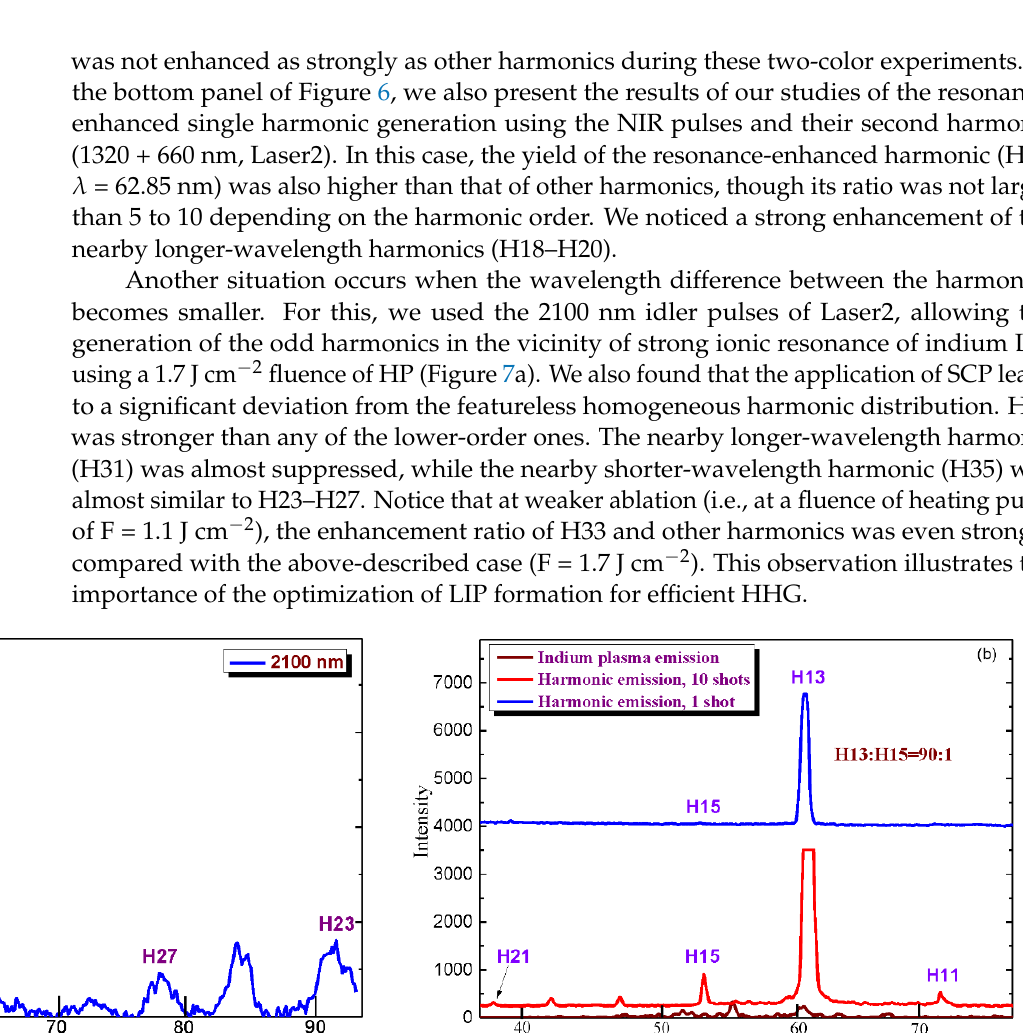
Figure 6. Raw images of plasma and harmonic spectra from the indium ablation. Upper panel: Plasma emission in the case of the over-excitation of In target. Second panel: HHG spectrum using SCP (800 nm, Laser1) at optimal ablation of target. Third panel: HHG spectrum using OTC (800 + 400 nm, Laser1). Fourth panel: HHG spectrum using OTC (1320 + 660 nm, Laser2).